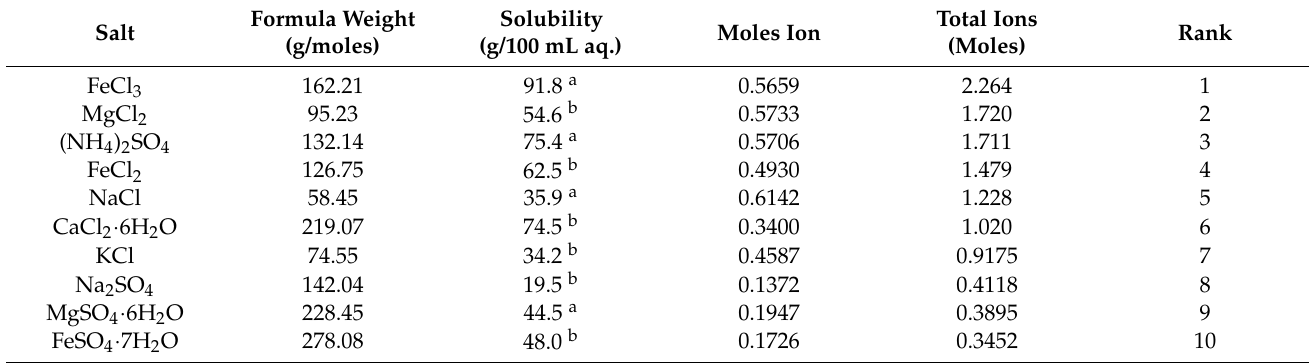
Table 6. Water solubility of common salts at 20 ◦ C.